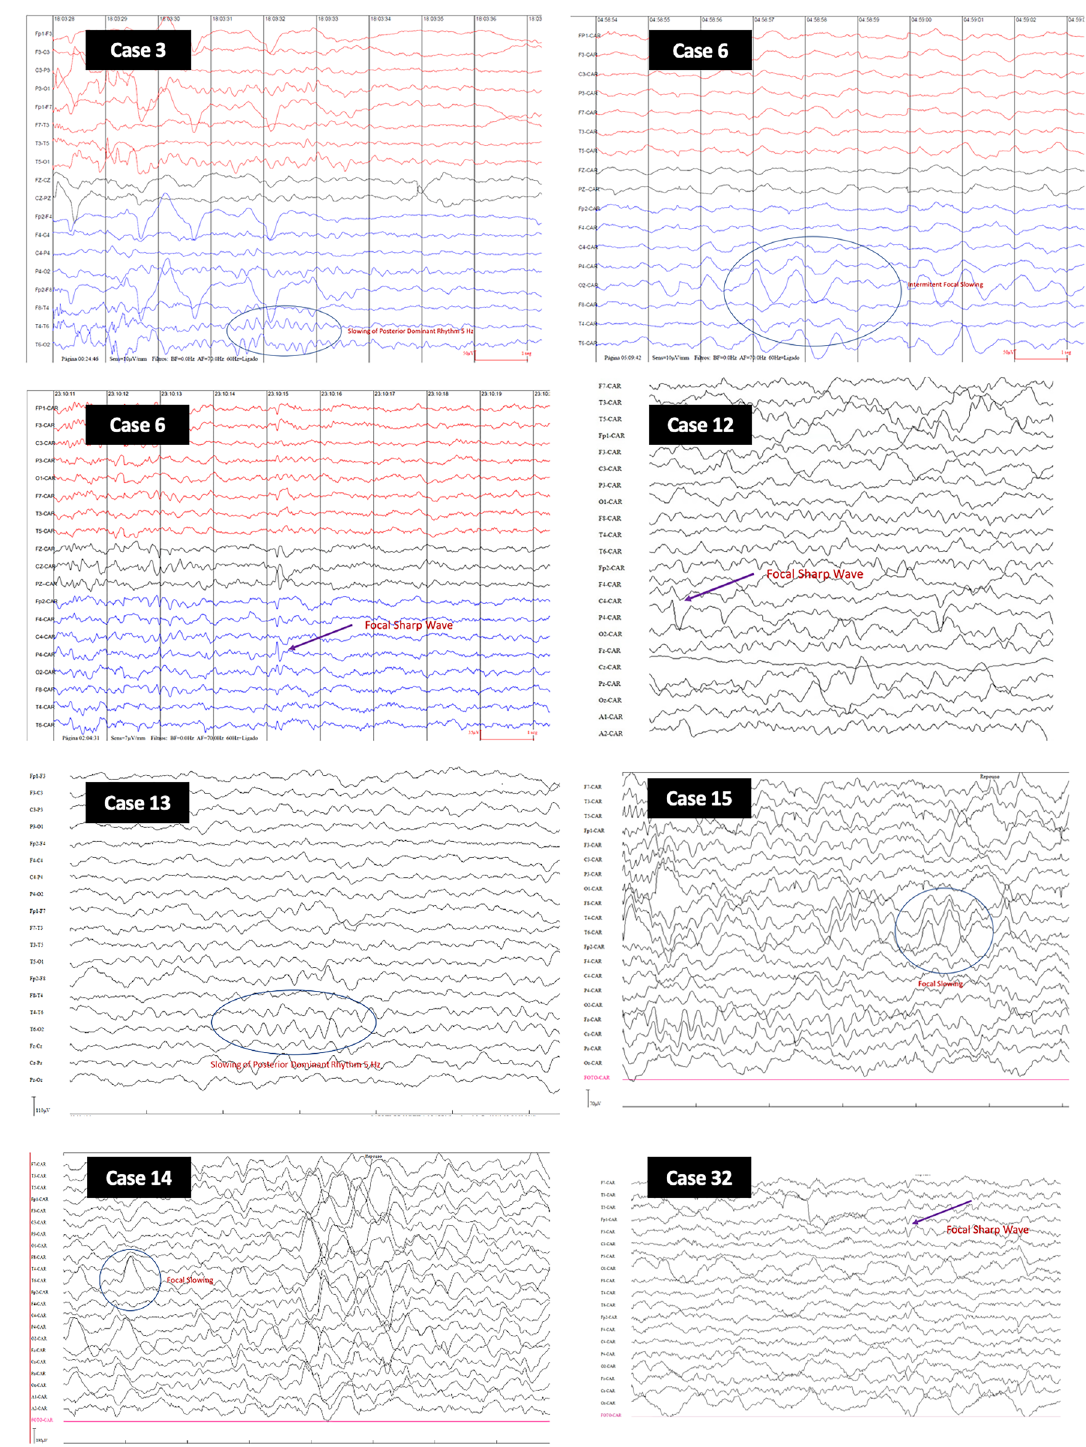
Figure 1. Some selected images from the electroencephalogram of seven patients highlighting findings considered suggestive of encephalopathy associated with